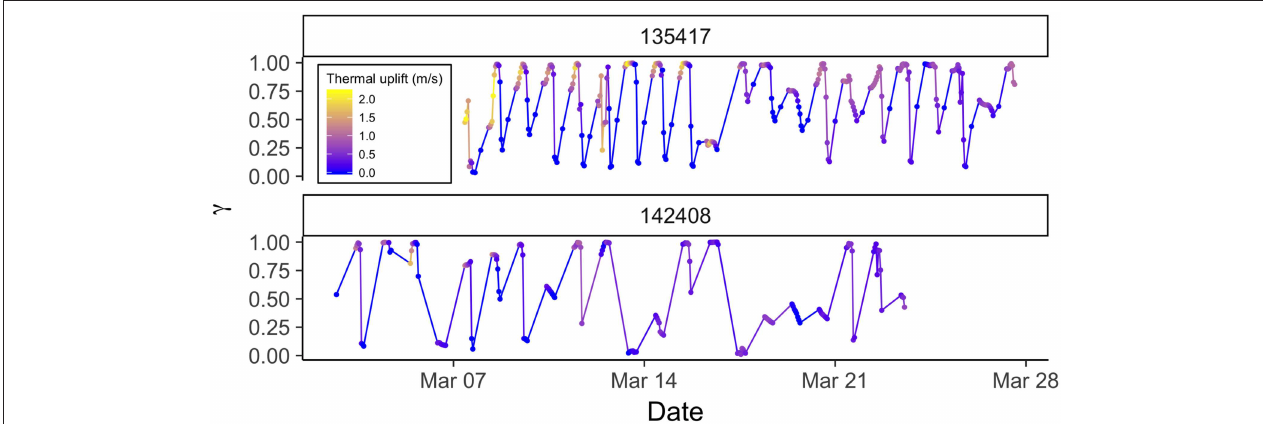
FIGURE 1 | Time series of behavior parameter γ from correlated random walk model with full behavioral process (orographic uplift, thermal uplift, and wind support as predictors) for two golden eagles during spring migration with PTTs reporting on different duty cycles. Upper panel is 13 hourly centered on solar noon plus one at midnight, and the lower panel is 8 hourly centered on solar noon. γ close to one reflect movements associated with migratory behavior, and γ close to zero stopover behavior. Points are times of observations, and lines are linear interpolations between points. Hue indicates intensity of thermal uplift, with yellow indicating greater and blue lower. Note the daily rhythm in behavior associated with intense thermal uplift, stopover periods of one or more days, and the intermediate periods suggesting fly-and-forage.